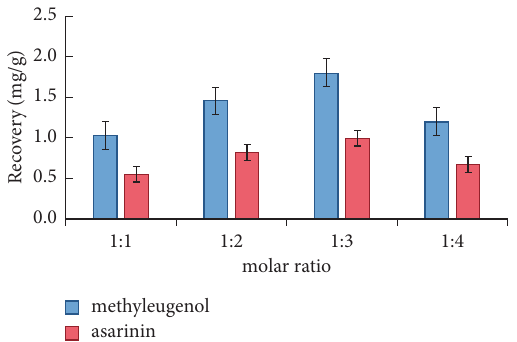
Figure 4: Effect of molar ratio, extraction conditions: sample amount, 50mg; DES volume, 1.5mL; ultrasonic temperature, 60 ° C; ultrasonic time, 30min; and vortex oscillation, 5 min.